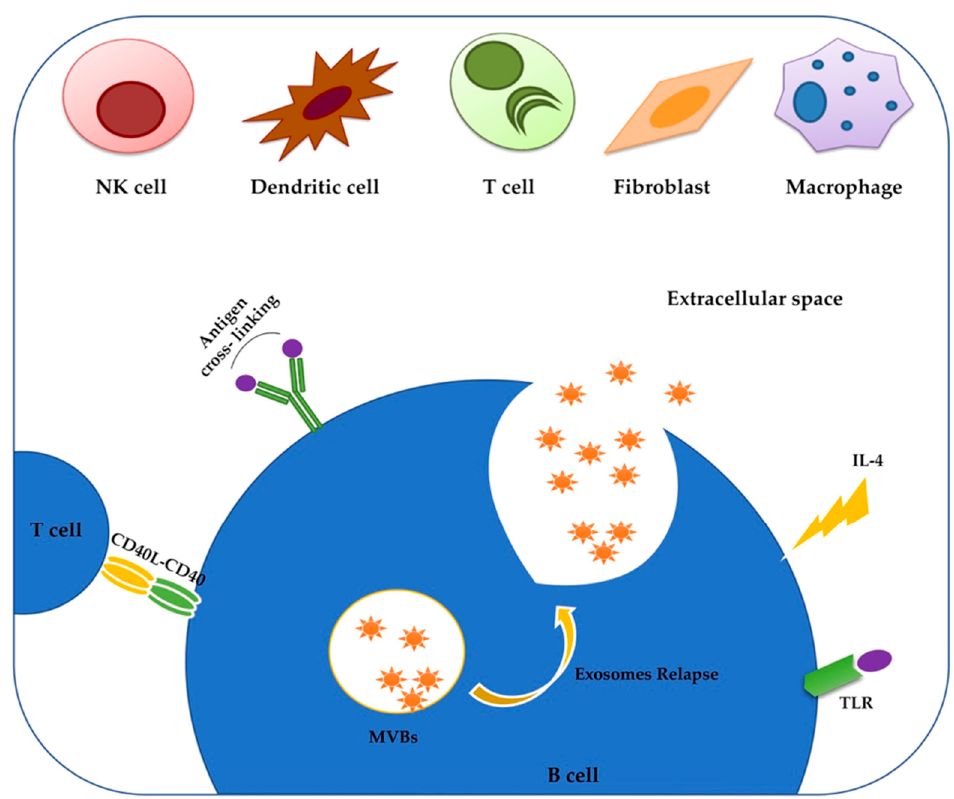
Figure 1. Exosomes relapse from a primary B cell after stimulation. Both ESCRT-dependent and ESCRT-independent mechanisms of exosomes relapse, require exogenous stimuli on several receptors on B-cell membrane (CD4, BCR, TLR, IL-4R) to start the production and secretion of exosomes. This induces the fusion of the multivesicular bodies (MVBs), containing the exosomes, with the plasma membrane. Via this process, the exosomes containing cytosolic components of parental cell are released into the extracellular compartment and move toward target cells, in which they can modulate different downstream processes.